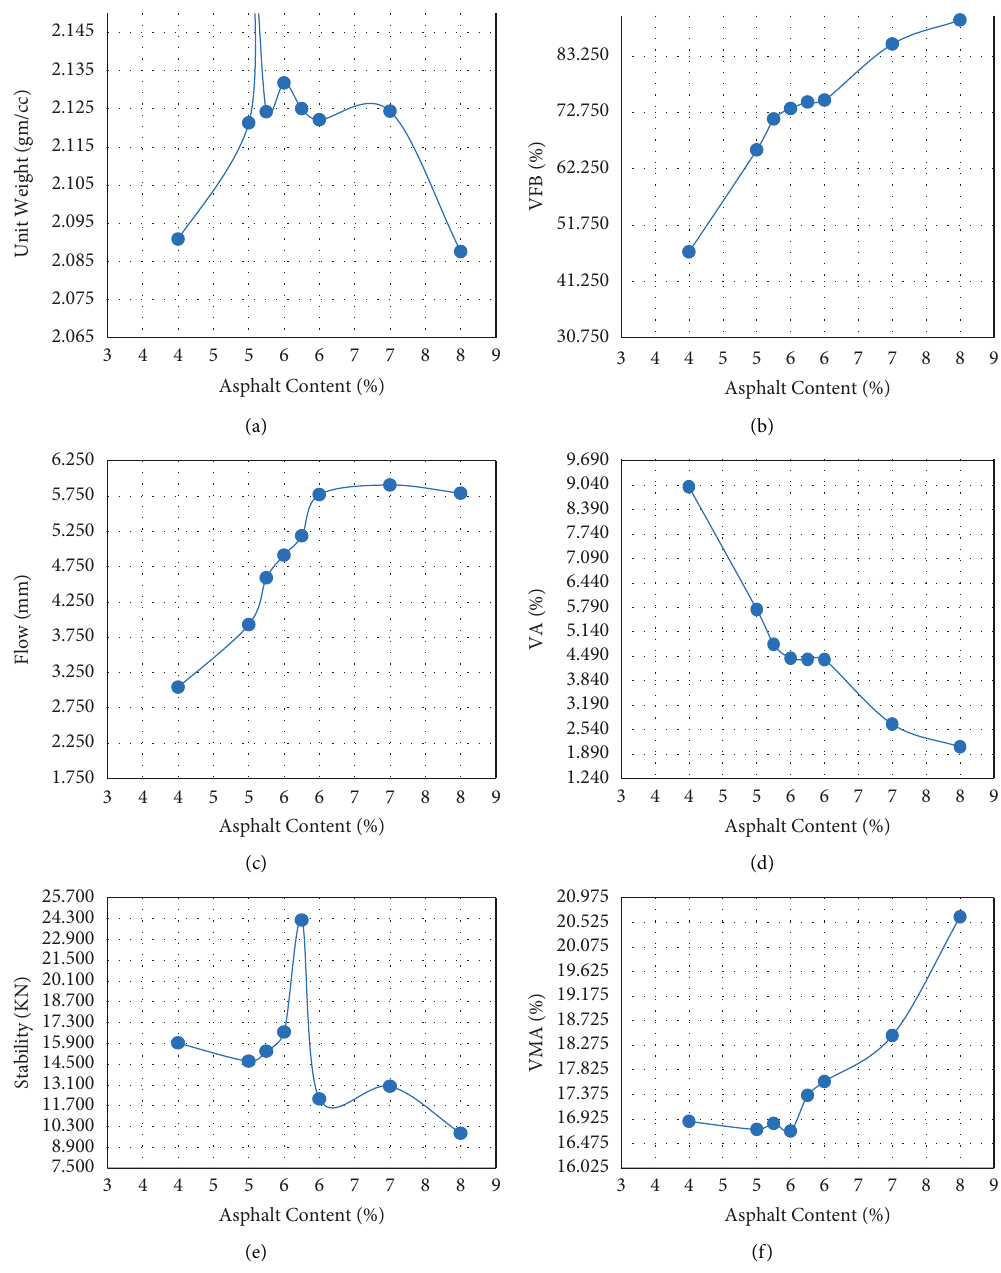
Figure 4: Marshall properties vs. asphalt contents for specimens prepared with CHA as filler (a–f). (a) Asphalt content vs. unit wt. (b) Asphalt content vs. VFA. (c) Asphalt content vs. flow values. (d) Asphalt content vs. air voids (VA). (e) Asphalt content vs. stability. (f) Asphalt content vs.